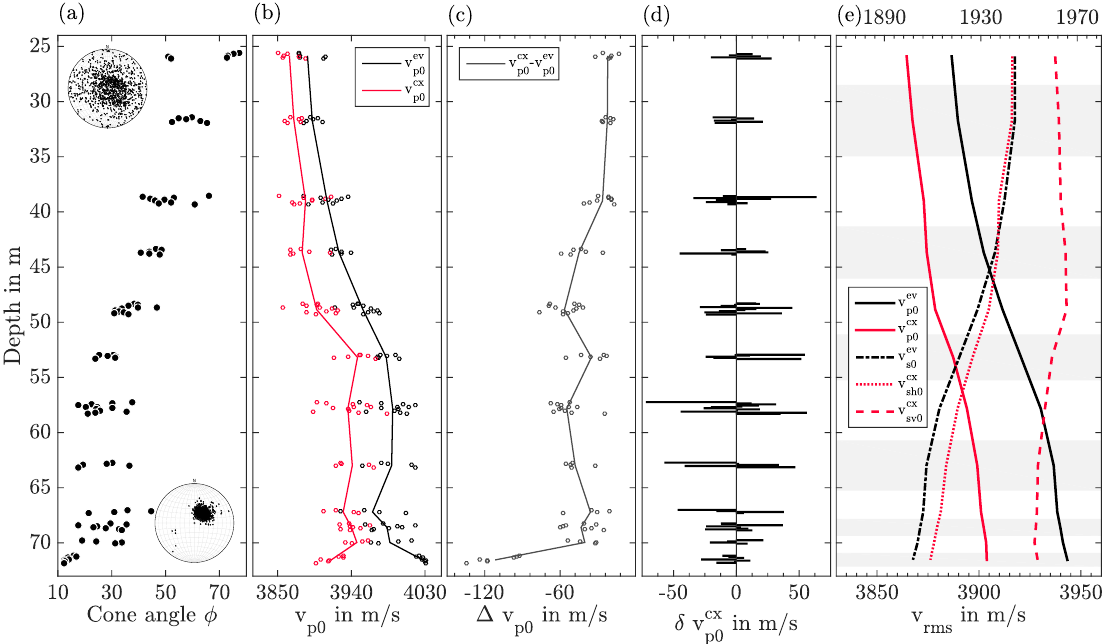
Figure 6. Comparison of zero-offset velocities calculated from KCC fabric data via ev and cx frameworks. Panel (a) shows cone angles derived from eigenvalues following Diez and Eisen (2015) and Schmidt diagrams illustrating the distribution of c axes in the upper and the lower part of the core (projection of c axes onto the horizontal ice-core plane). Panel (b) presents the calculated P-wave velocities for the two frameworks for all thin sections (symbols) and the average velocities for each continuously sampled depth interval (lines). Panel (c) shows − v ev the difference (cid:49)v p0 = v cx per sample and per interval average. Panel (d) illustrates the velocity change δv cx p0 p0 between subsequent 10cm sections at depths d i . Panel (e) shows the rms velocities which were calculated from the averaged velocities for layers centred around the measurement intervals (alternating shading); S-wave velocities refer to the upper x axis and P-wave velocities to the lower x axis.